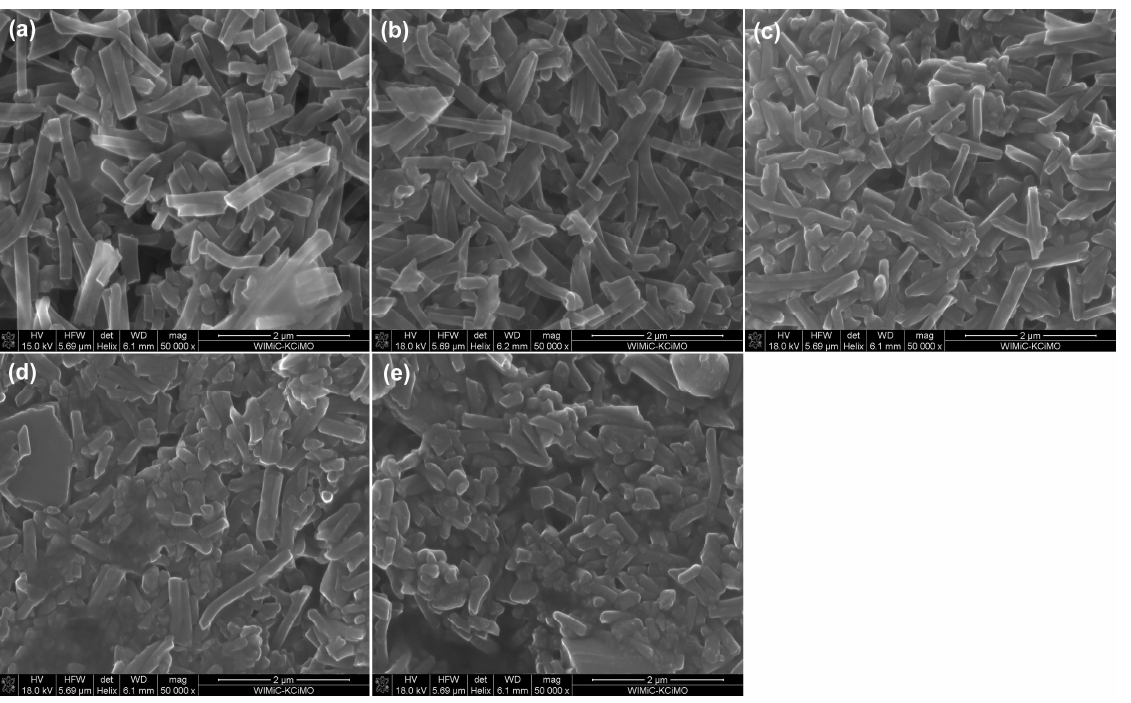
Figure 1. SEM microphotograph of fragmented eCNFs ( a ) eCNF750, ( b ) eCNF1000, ( c ) eCNF1500, ( d ) eCNF1750 and ( e ) eCNF2000.